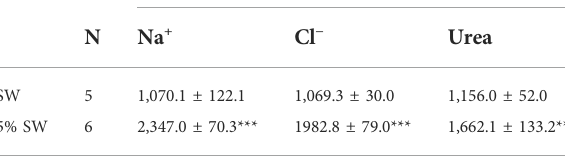
TABLE 3 Estimated reabsorption rate of major osmolytes in the red